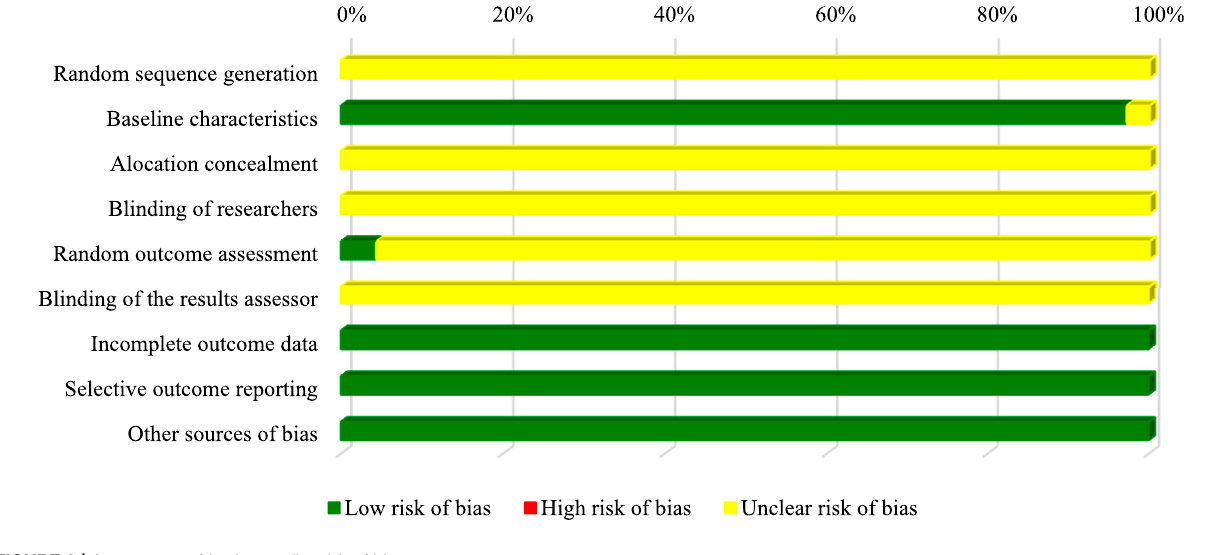
FIGURE 3 | Assessment of in vitro studies risk of